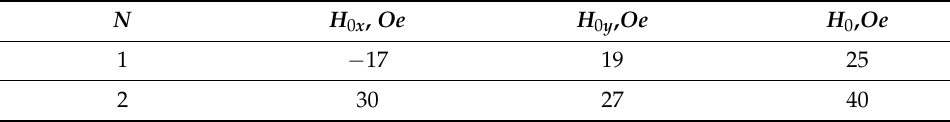
Table 1. For the first stripe with a = 3 µ m and b = 1 µ m.